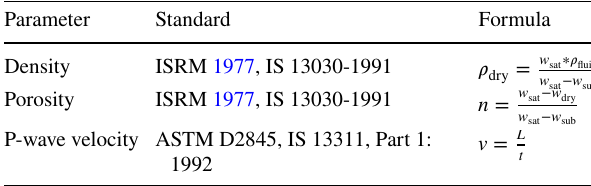
Table 2 Standards for determination of different physical parameters of rock